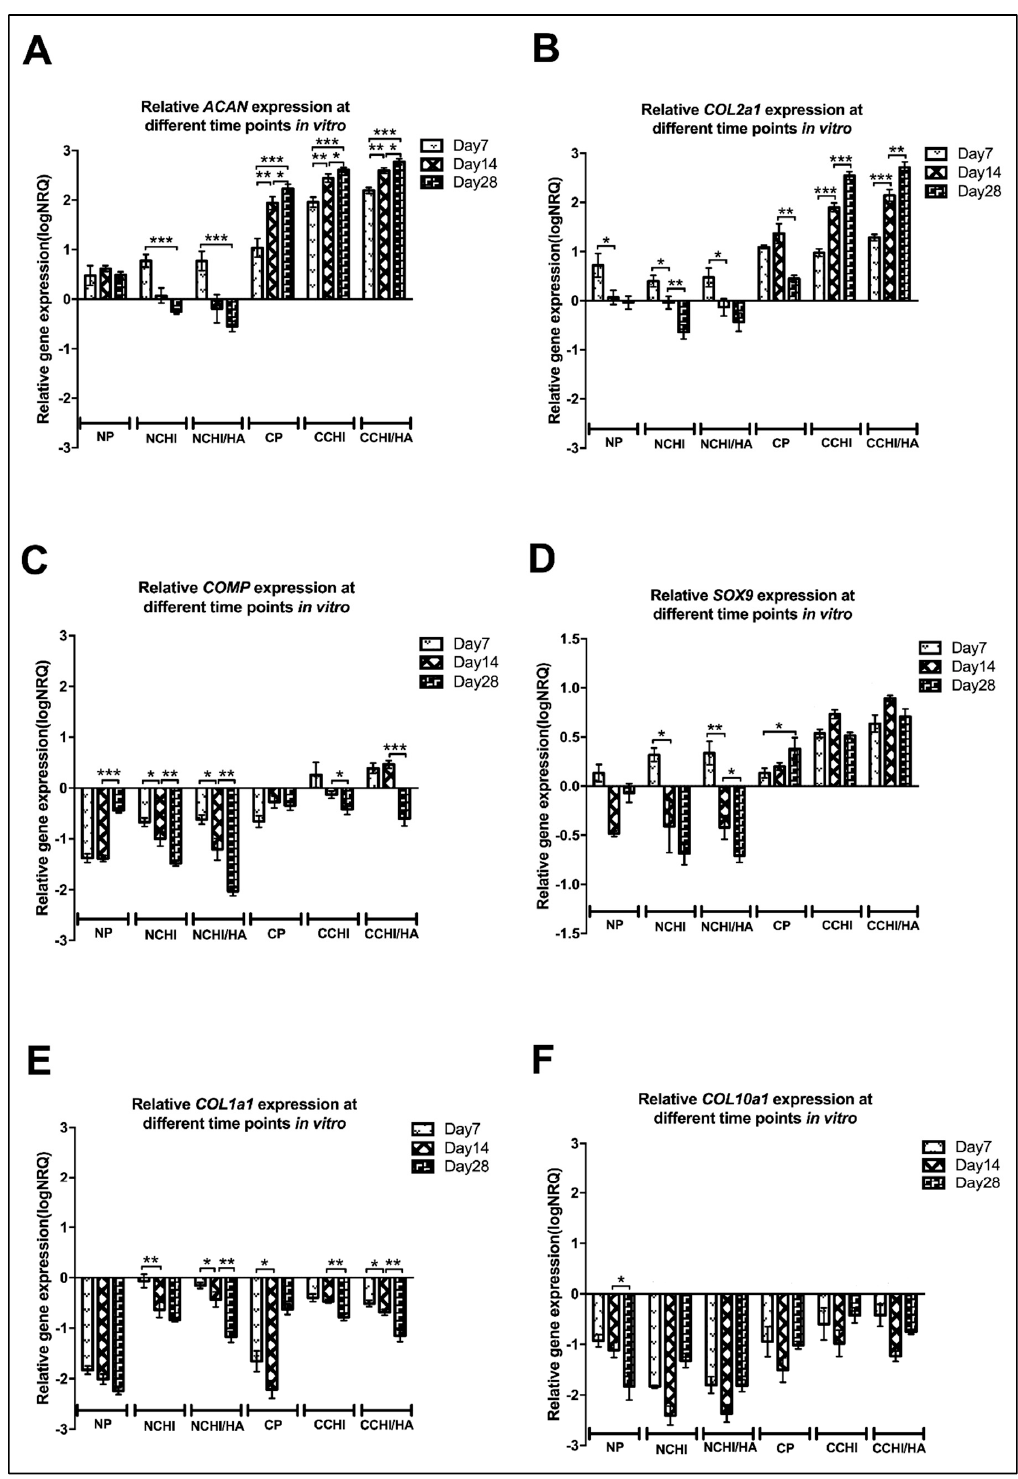
Figure 7. Relative quantitative gene expression of ( A ) ACAN , ( B ) COL2A1 , ( C ) COMP , ( D ) SOX9 , ( E ) COL1A1 , and ( F ) COL10A1 in di ff erent culture groups (N = normal medium; C = chondrogenic medium, P = 3D Pellet; CHI = chitosan sca ff olds, CHI / HA = chitosan with hyaluronic acid sca ff old) at di ff erent time points (Day 7, 14, and 28) (* p < 0.05, ** p < 0.01, *** p < 0.001). The baseline 0 represents untreated hADSCs in the monolayer, which was the normalization